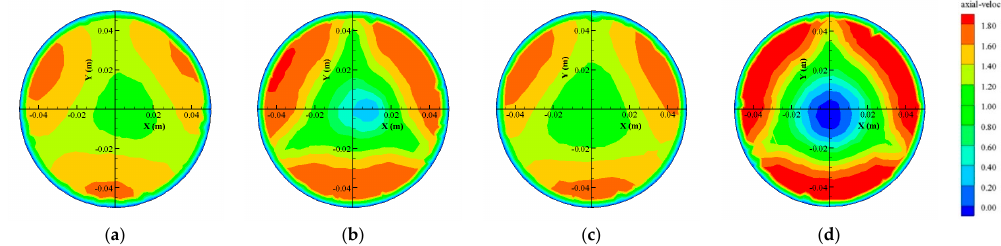
Figure 6. Axial flow velocity distributions of the downstream sections of capsules. ( a ) Z d = 0.225 m, L/D = 2; ( b ) Z d = 0.075 m, L/D = 2; ( c ) Z d = 0.225 m, L/D = 1.67; ( d ) Z d = 0.075 m, L/D = 1.67.